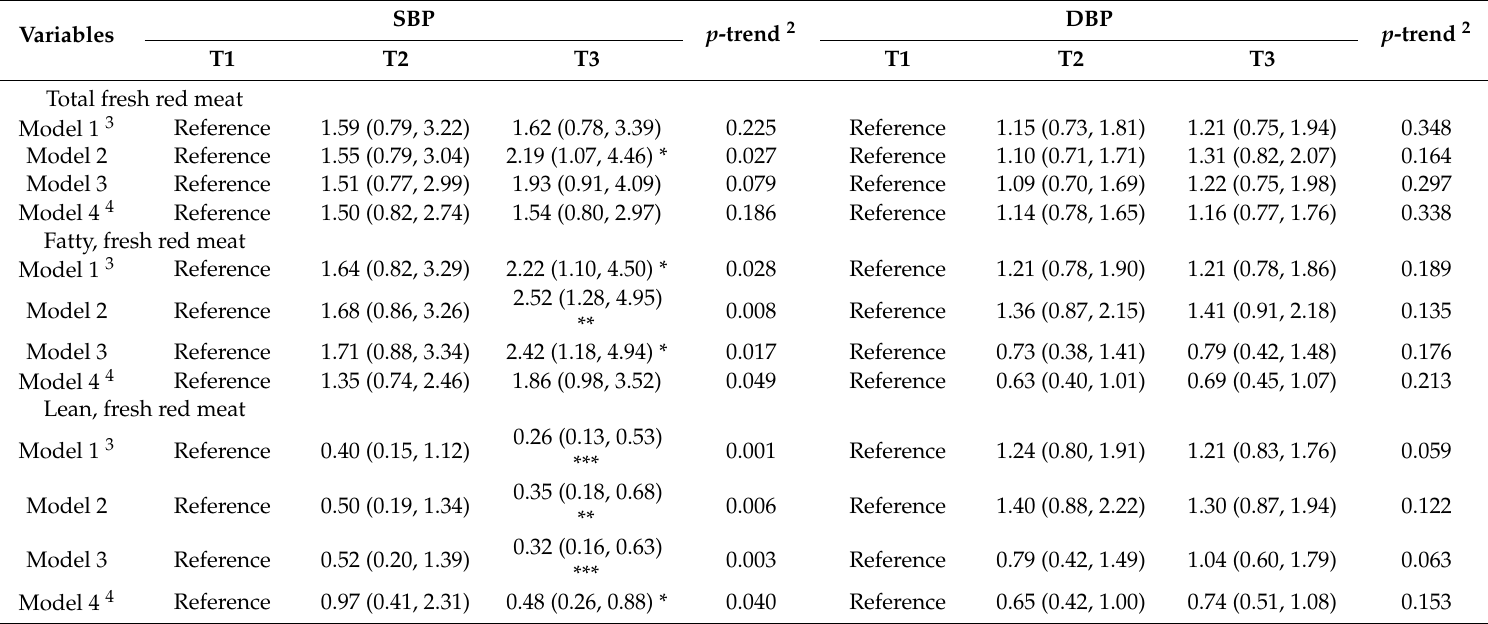
Table 3. Regression coe ffi cients (95% CI) of SBP and DBP according to level of intake of total fresh red meat and subtypes among female Chinese, CHNS 1 .